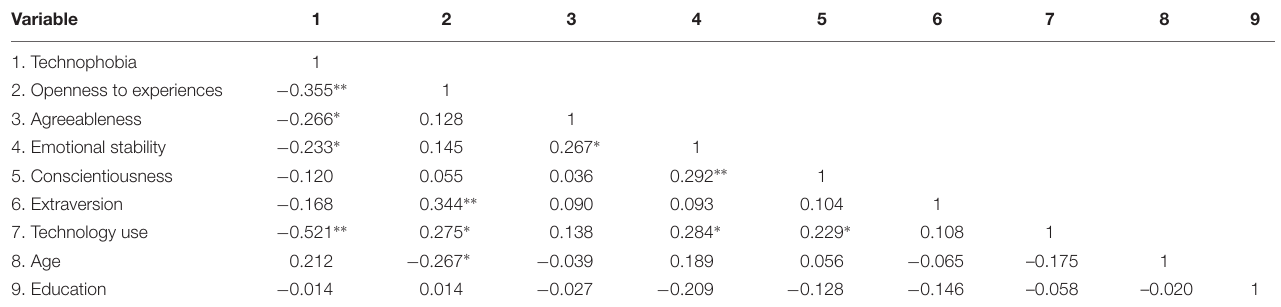
TABLE 3 | ANCOVA analysis on cognitive map formation, reading medium, and technophobia.